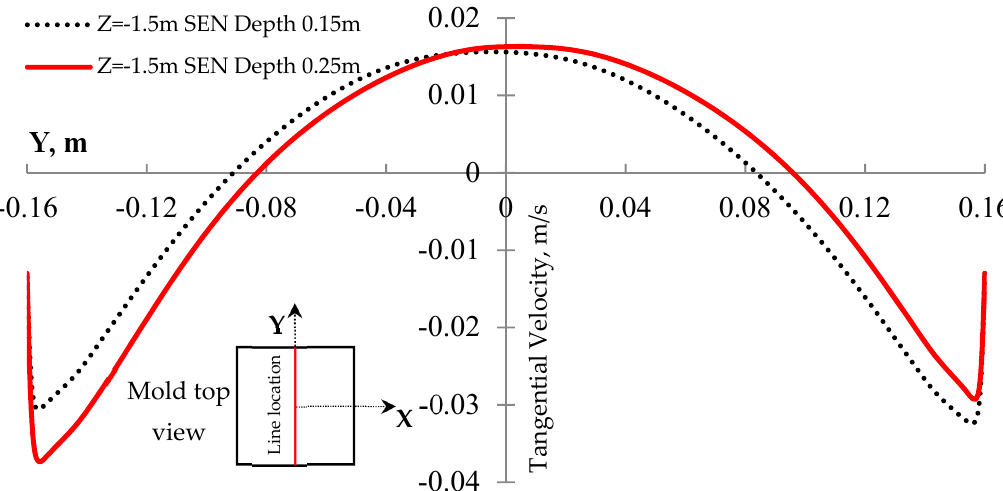
Figure 4. Vertical steel flow velocity along horizontal lines in different mold depths.